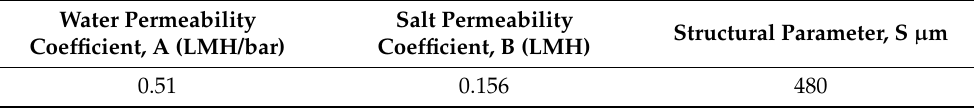
Table 1. The cellulose triacetate (CTA) membrane characteristics.